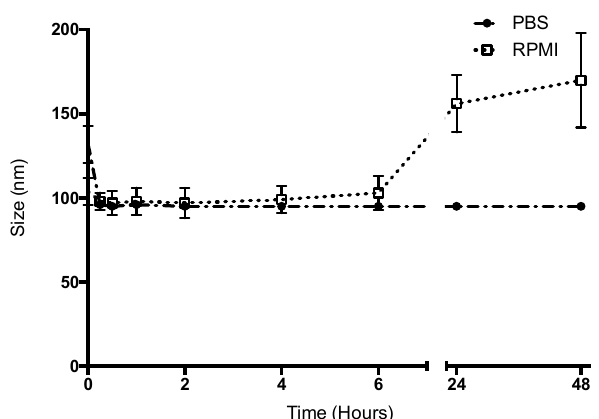
Figure 4. Stability of Hyaluronic acid nanocapsules at 37 °C for 48 h in physiological conditions (PBS, black circles) and cell culture media buffer (supplemented RPMI, white squares).